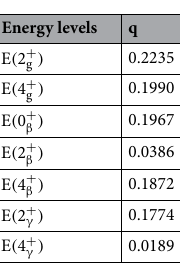
Table 4. The values of the q parameter for different energy levels of the new regular nuclei